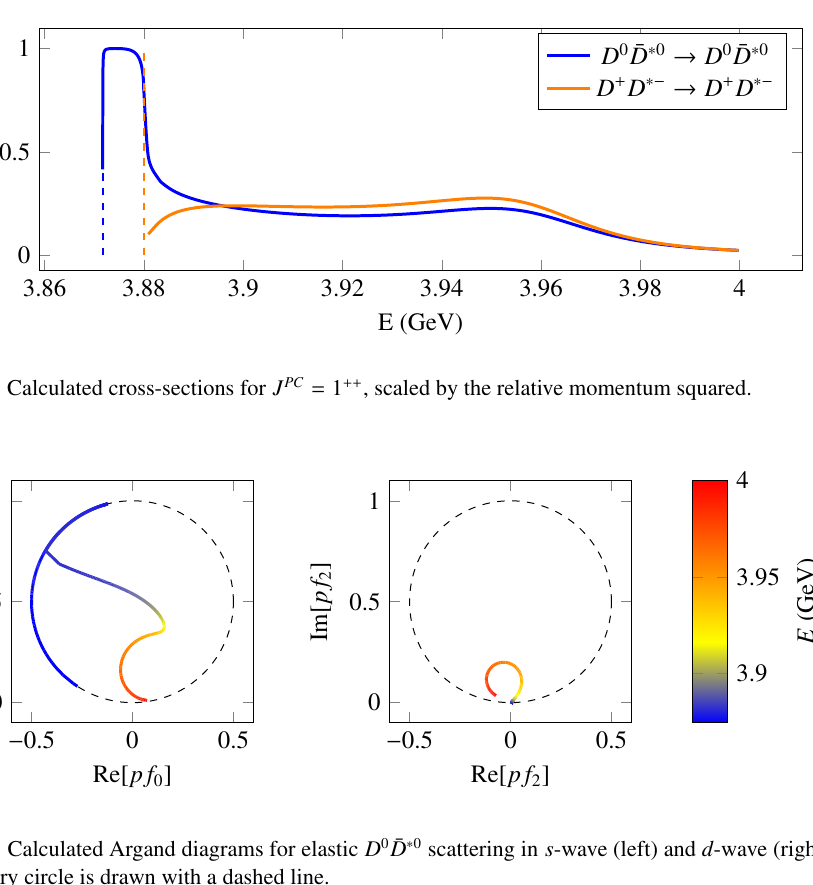
Figure 5. Calculated Argand diagrams for elastic D 0 ¯ D ∗ 0 scattering in s -wave (left) and d -wave (right). The unitary circle is drawn with a dashed